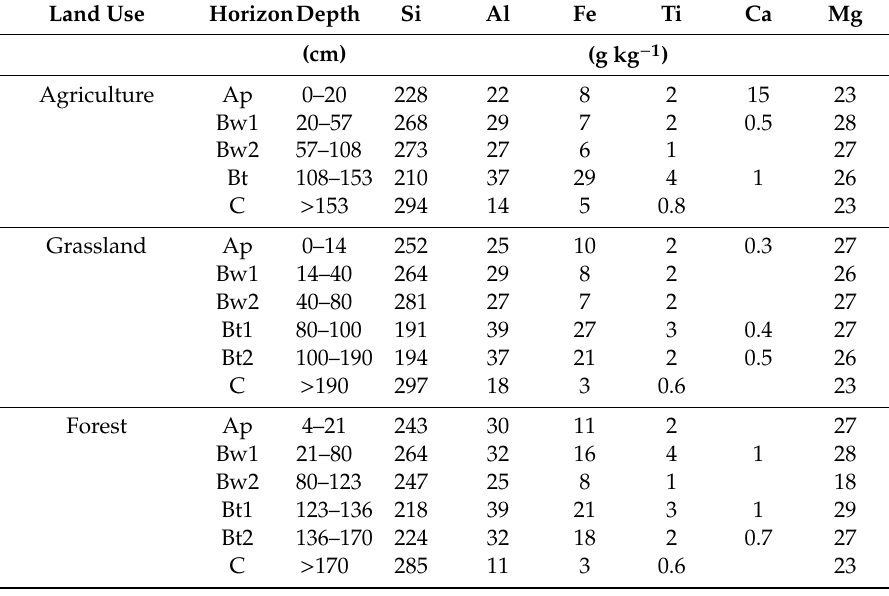
Table 3. Elemental analysis for three sandy Alfisols under di ff erent land use in the Wisconsin Central Sands. Data from